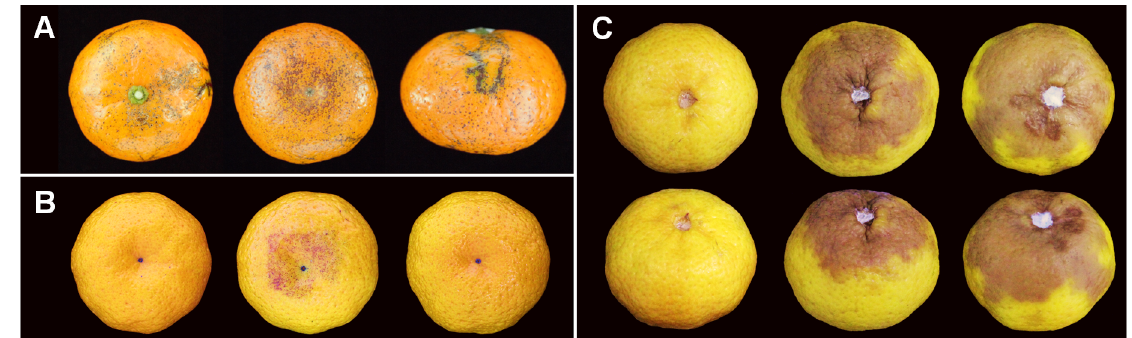
Figure 3. ( A ) Nanfengmiju fruit from Jiangxi Province showing symptoms of melanose. ( B ) pathogenicity stimulating melanose symptoms on mandarin fruit. For each strain, 300 µ L of conidial suspensions is dropped on a piece of cotton, and then placed on the bottom of the fruit. The inoculated fruit are placed in a plastic chamber maintain 95% relative humidity, incubated at 25 ◦ C 12 h of light and 12 h of dark for 15 days. ( C ) pathogenicity stimulating stem-end rot symptoms on stem-end of mandarin fruit. The stems of citrus fruit are removed carefully, and 10 µ L of conidial suspension of each strain is dropped there and incubated at 25 ◦ C in the dark for 7 days. Note: B and C , from left to right are sterile water, conidial suspensions of D. citri (isolate NFHF-8-4) and conidia suspensions of D. passifloricola (isolate NFIF-3-21), respectively.